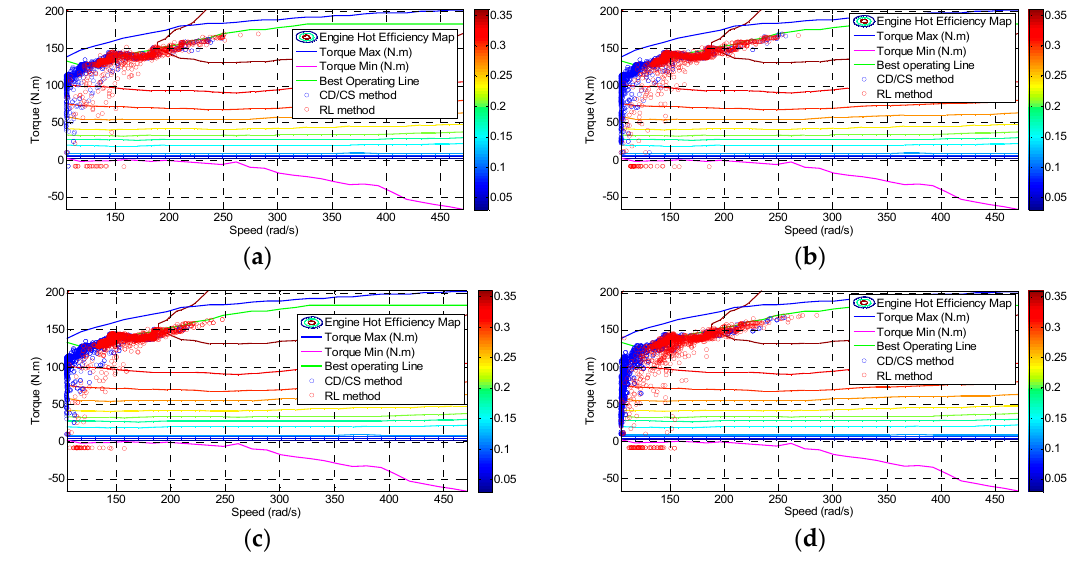
Figure 12. Fuel consumption results. ( a ) Cycle 1; ( b ) Cycle 2; ( c ) Cycle 3; and ( d ) Cycle 6.